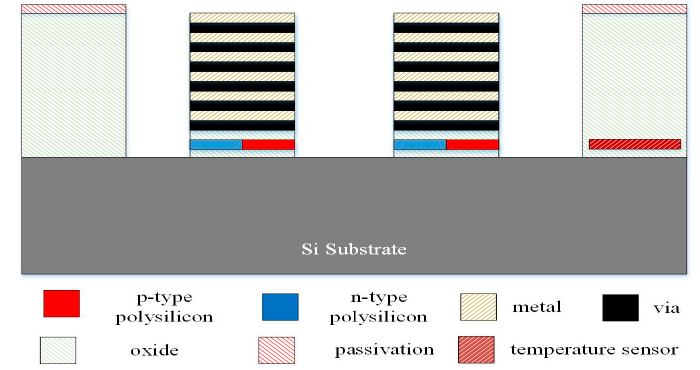
Figure 7. Cross section of the TEMH after etching of the silicon oxide layer.